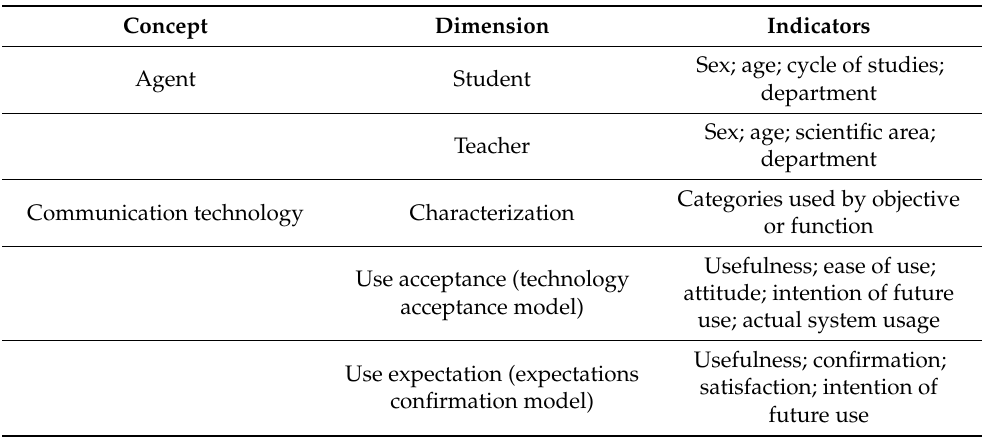
Table 1. Model of